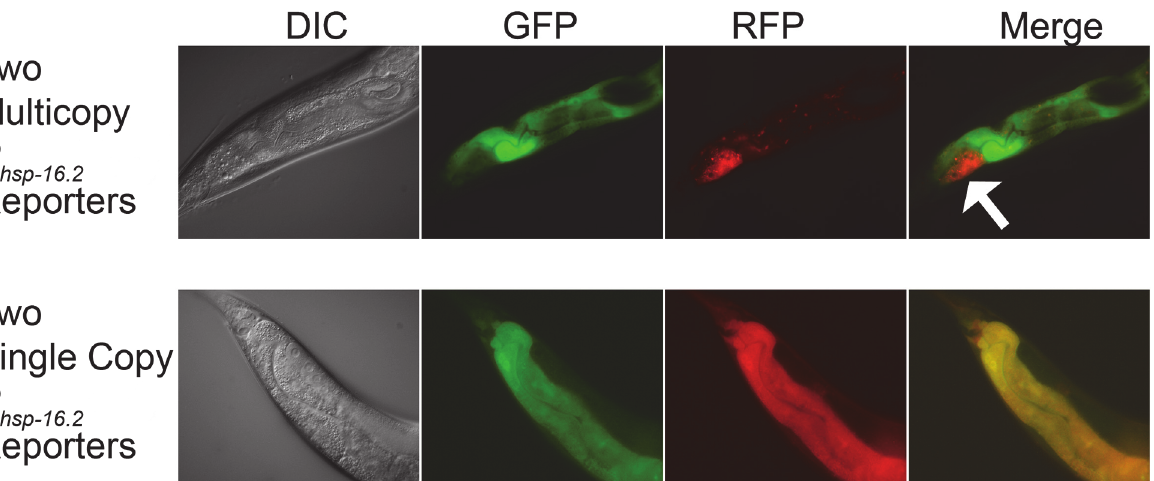
Fig 6. Expression of two differently colored P hsp-16 . 2 reporters in the same animal using multicopy and single copy reporters. DIC micrographs and fluorescent images show the three posterior-most intestinal cell rings (rings VII-IX). In the figure, posterior is on the left and dorsal on the top. Top row shows an animal expressing two multicopy reporters. Bottom row shows an animal expressing two single copy reporters. In about 1/3 of the animals expressing two multicopy reporters, there is a dramatic difference in the expression of the reporters in at least one cell. The strong bias toward expression of the red allele in int9R (white arrow, top row, fourth panel) occurred in slightly more than half of the animals showing differential expression (12/21). We did not observe such pronounced expression bias in the intestine cells of the animals expressing the two single copy reporters (typical image shown in bottom row).